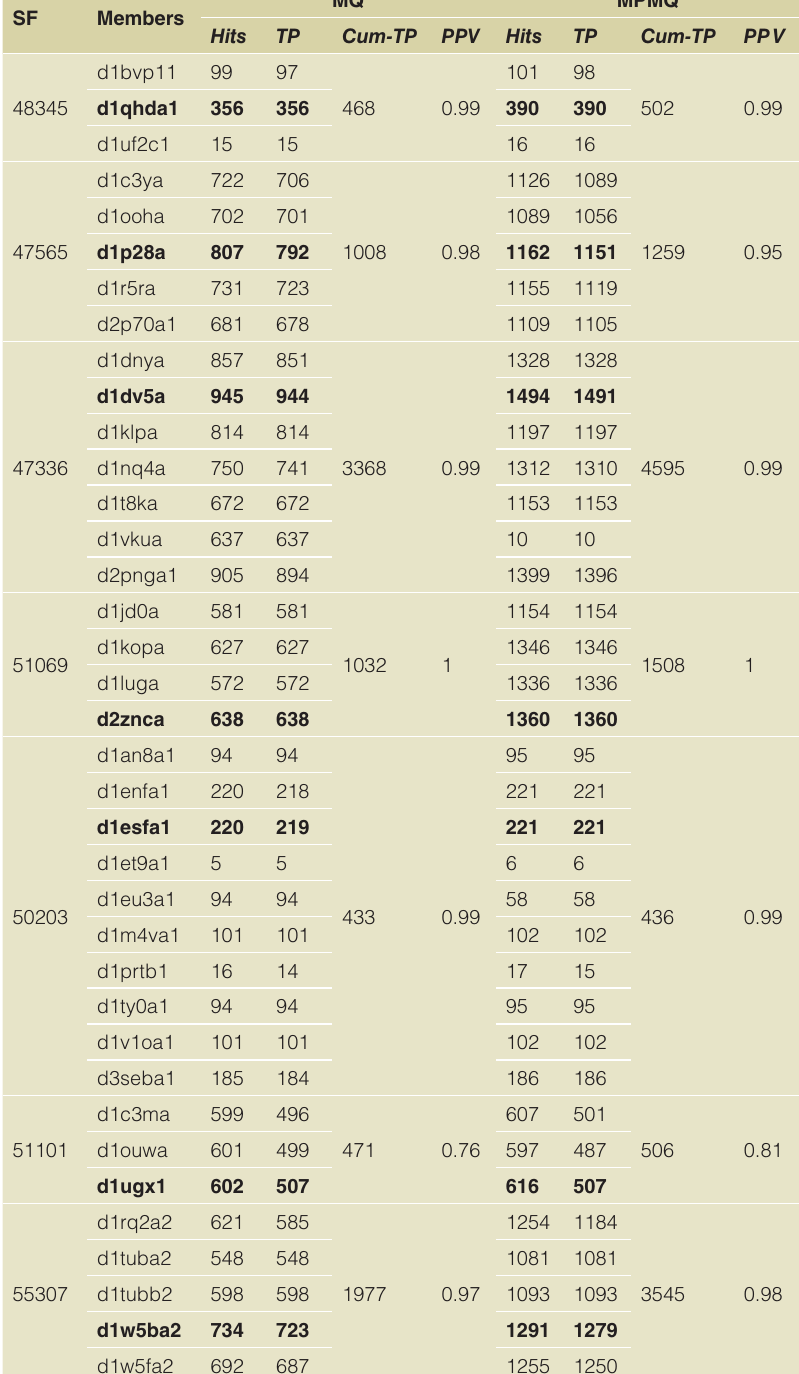
Table 2. Comparison of MQ (Multiple Query) and MPMQ (Multiple Patterns – Multiple Query) approaches for 12 superfamilies (SF – Superfamily, TP – True Positive, Cum-TP – Cumulative true positives, PPV – Positive Prediction Value, bold faced entries are BRS (Best Representative